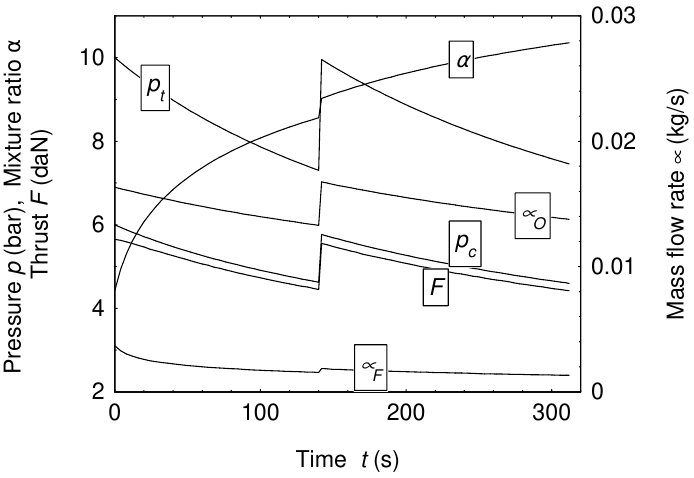
Figure 2. Blow down with a single-shot